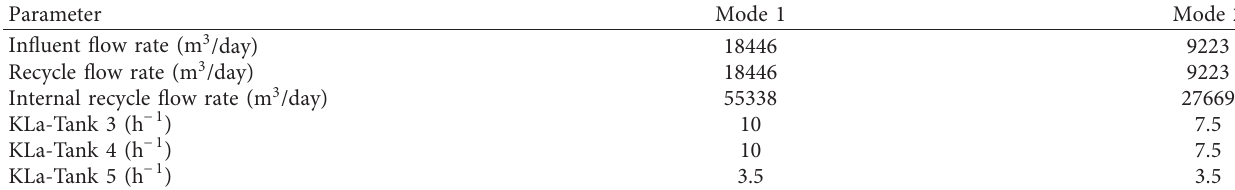
Figure 7: Process layout of the WWTP. Table 5: FAR for all test conditions on TE process.